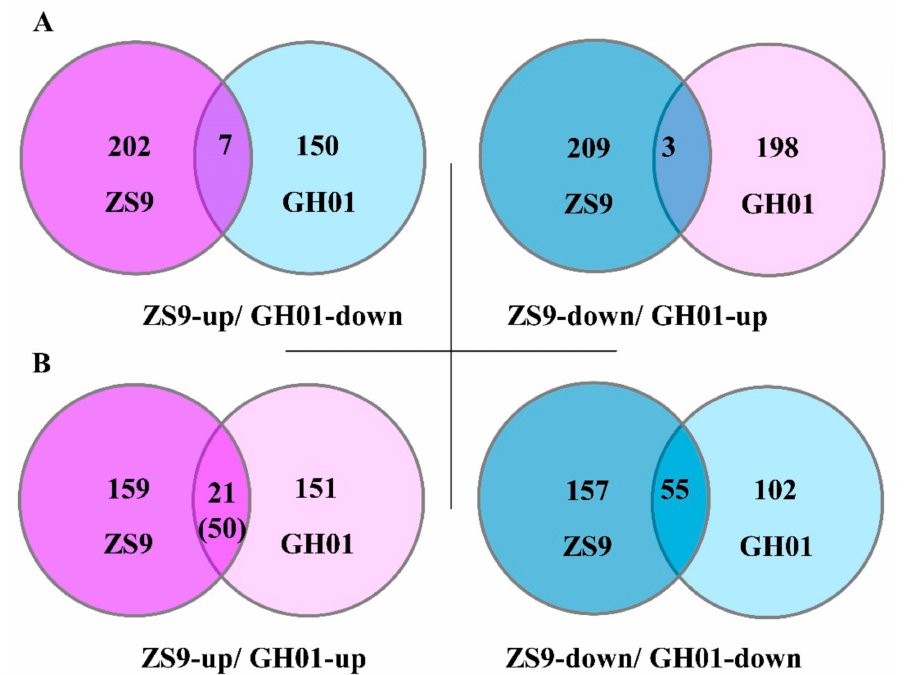
Figure 6. Venn diagram for the number of differentially expressed proteins with the same or opposite tendency between ZS9 and GH01—the threshold ratio is set as >1.20 or